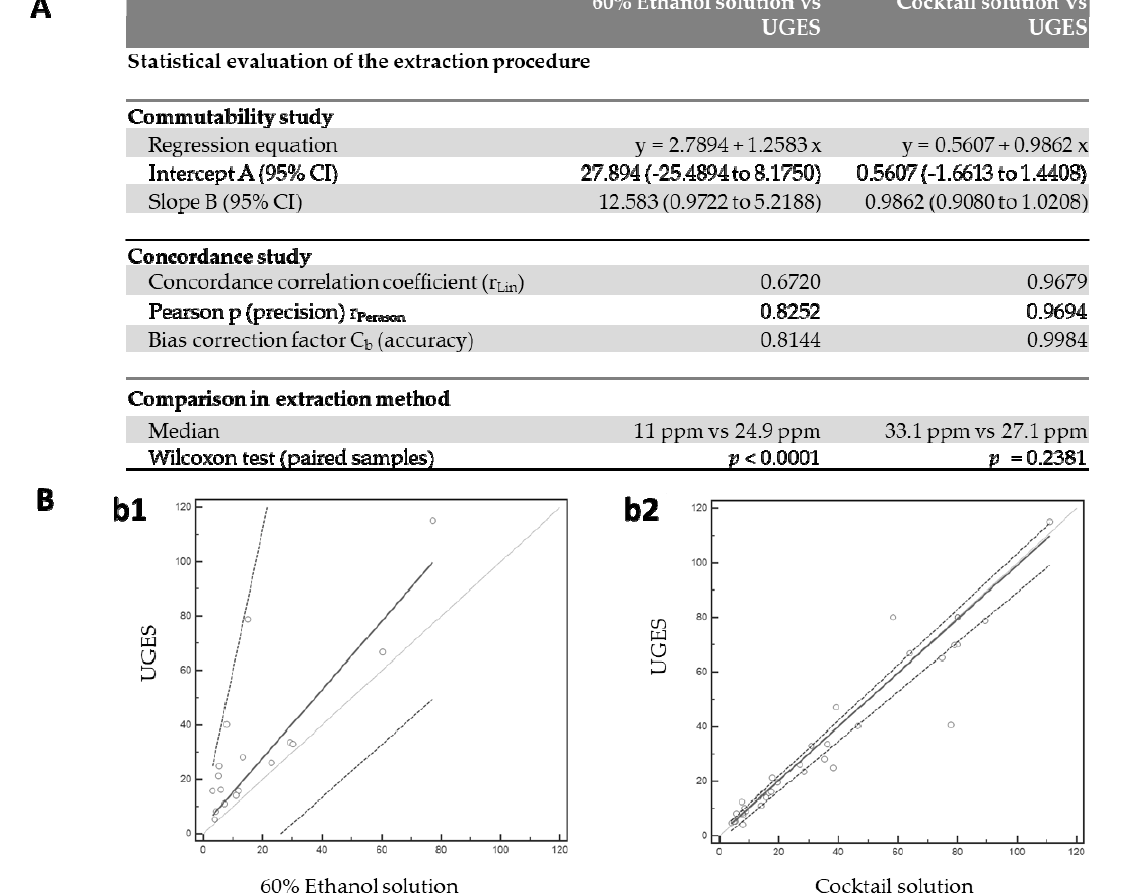
Figure 2. Statistical evaluation of the extraction procedure. ( A ) Comparison of agreement between pairs of assays for results of the food samples by sandwich ELISA using different extraction solutions different. Statistical analysis was performed by the Wilcoxon test. The p -values are given in the figure. ( B ) Scatter diagram with regression line and concordance bands for regression line; ( b1 ) representation of the 60% ethanol solution versus Universal Gluten Extraction Solution (UGES); ( b2 ) representation of the Cocktail solution versus UGES. The solid lines represent the regression line drawn for the food samples, and the dashed lines represent the 95% prediction